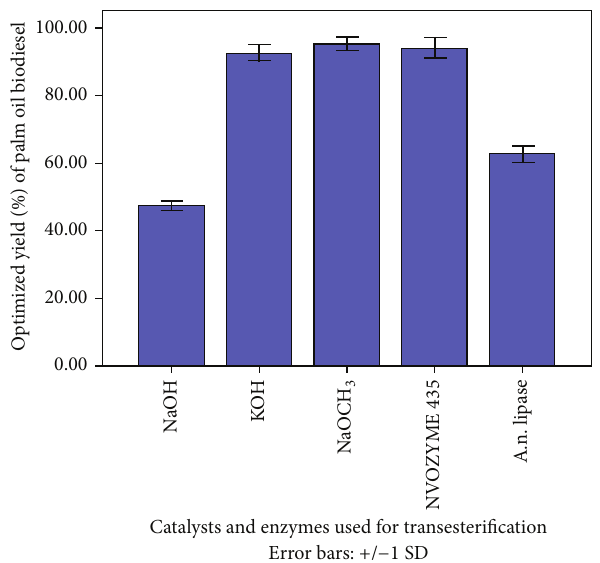
Figure 2: Optimized palm oil biodiesel yield (%) and ± standard deviation for chemical and enzymatic